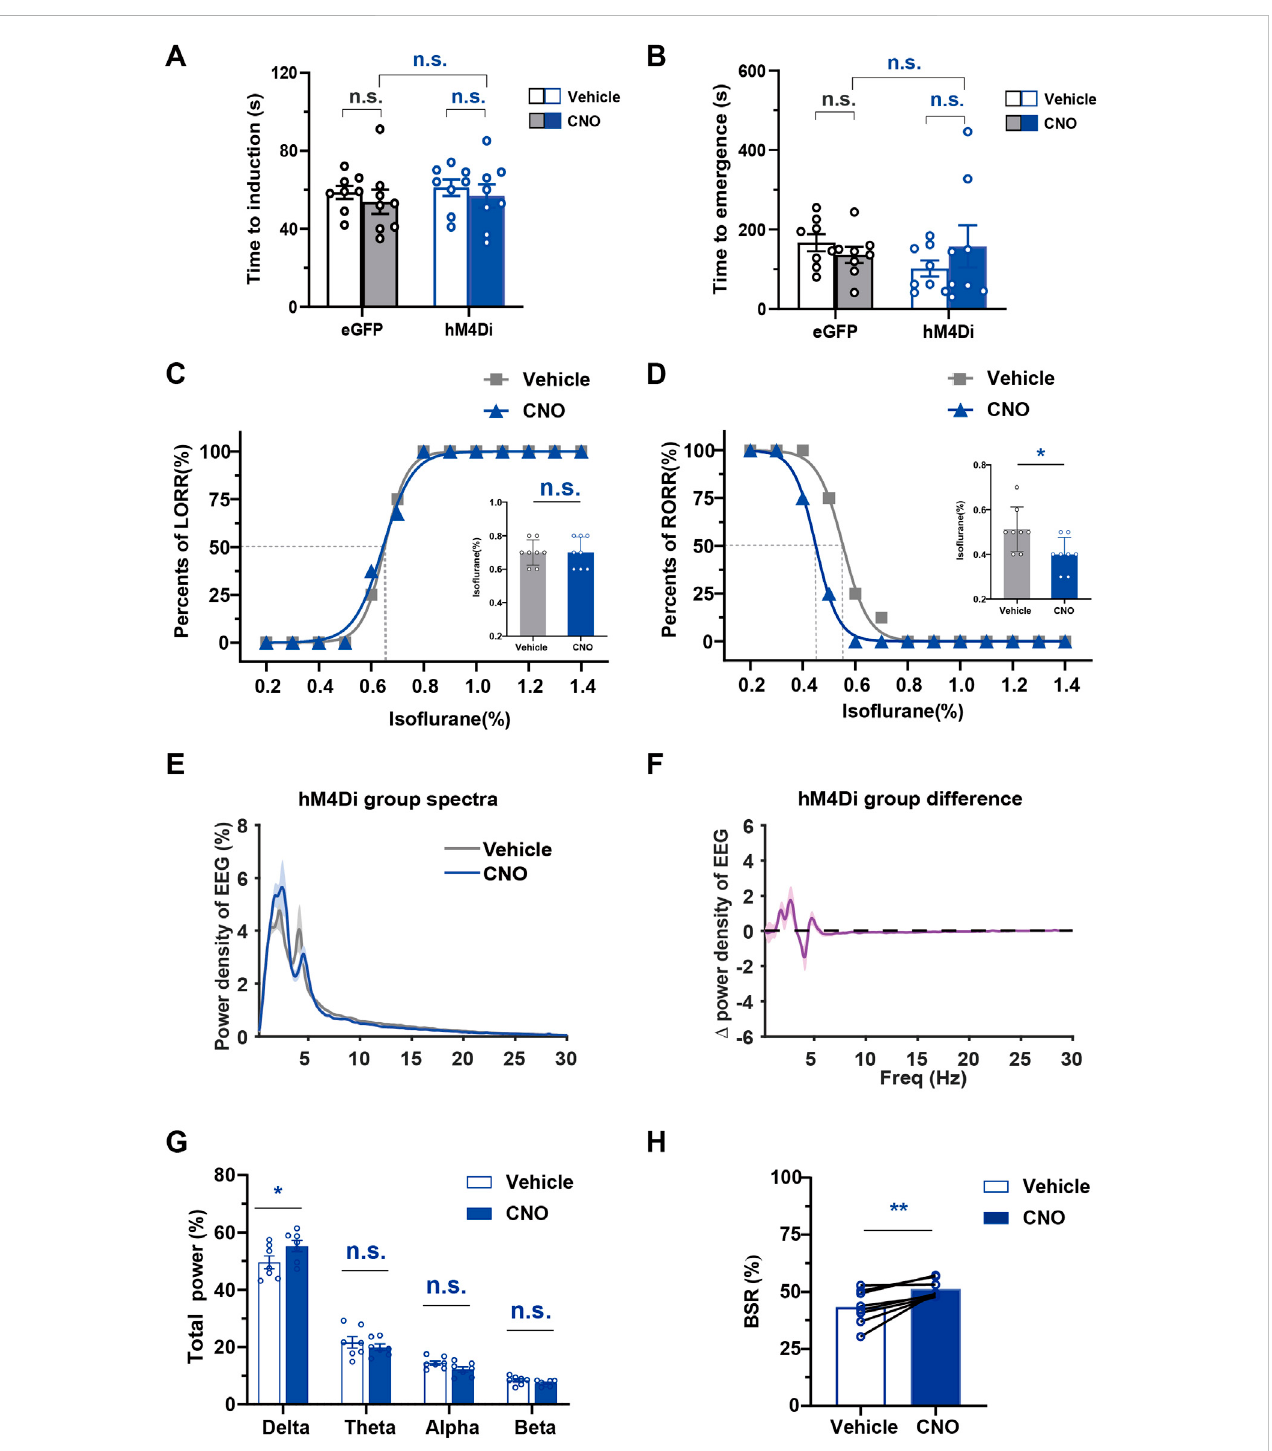
FIGURE 6 The effect of chemogenetic PBN astrocyte inhibition on the induction and emergence from iso fl urane anesthesia, and the EEG under iso fl urane anesthesia (A) EffectsofchemogeneticinhibitionofPBNastrocytesontheLORRtimeunder1.4%iso fl uraneanesthesia.Two-wayrepeated-measuresANOVA ( n = 8). (B) Effects of chemogenetic inhibition of PBS astrocytes on the RORR time under 1.4% iso fl urane anesthesia. Two-way repeated-measures ANOVA ( n = 8). (C) The dose-response curve shows the percentage of mice showing LORR as the iso fl urane concentration gradually increased after vehicle or 3 mg/kg CNO injection in hM4Di group. Inset: the iso fl urane concentrations at which each mouse exhibited LORR are shown. Paired t -test ( n = 8). (D) The dose-response curve shows the percentage of mice showing RORR as the iso fl urane concentration gradually decreased after vehicle or 3 mg/kg CNO injection in hM4Di group. Inset: the iso fl urane concentrations at which each mouse exhibited RORR are shown. Paired t -test ( n = 8). (E) Normalized power densities of EEG signals in hM4Di group after injection of the vehicle or 3 mg/kg CNO. Shadow areas represent mean ± SEM ( n = 7). (F) Differences in power densities of EEG signals in hM4Di group after injection of 3 mg/kg CNO and the vehicle. Shadow areas represent mean ± SEM ( n = 7). (G) Relative EEG power after vehicle or 3 mg/kg CNO injection in hM4Di group during .8% iso fl urane anesthesia. Paired t -test ( n = 7). (H) Statistics showing the change in BSR after vehicle and 3 mg/kg CNO injection in hM4Di group during 1.0% iso fl urane anesthesia. Paired t -test ( n = 8). Values represent the mean ± SEM; * p < .05, ** p < .01 shows signi fi cant differences between the vehicle and experimental